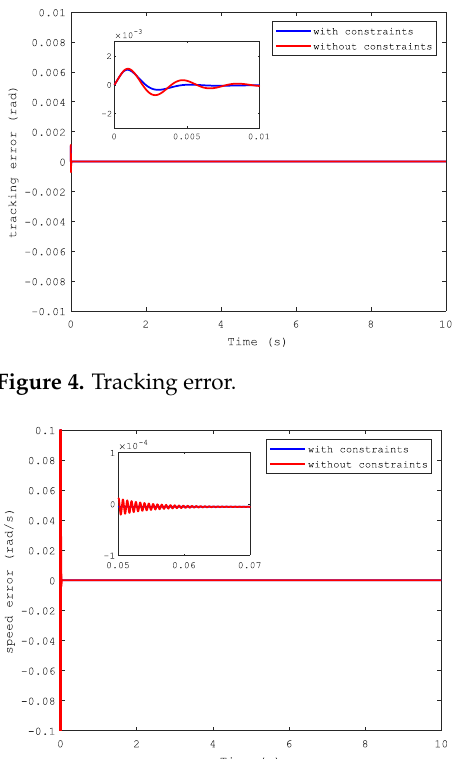
Figure 3. Position tracking performance: ( a ) with constraints; ( b ) without constraints.